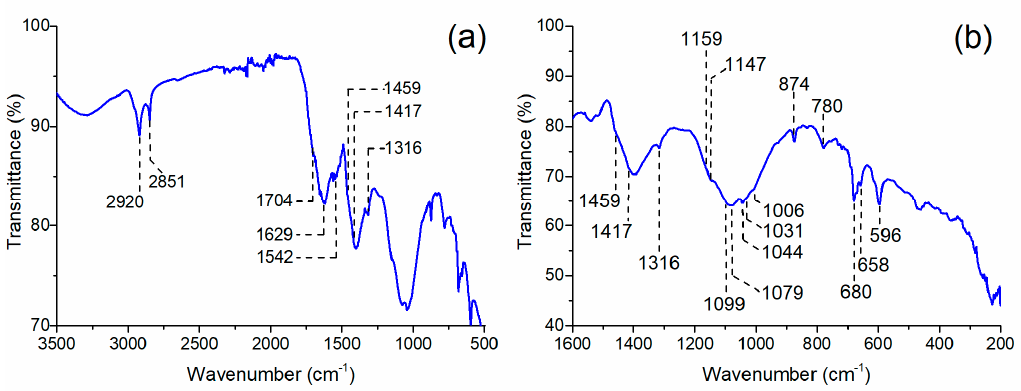
Figure 8. ATR-FTIR spectra of the blue areas in the range 3500 ÷ 500 cm − 1 ( a ) and in the range 1600 ÷ 200 cm − 1 ( b ). In addition to spectral features common with gold varnish, characteristic peaks and shoulders (1079, 1044, 690, 680, 671, 658, 616, and 596 cm − 1 ) attribute the blue pigment as indigo on a lead carbonate substrate, which is coupled with the presence of sulphates.